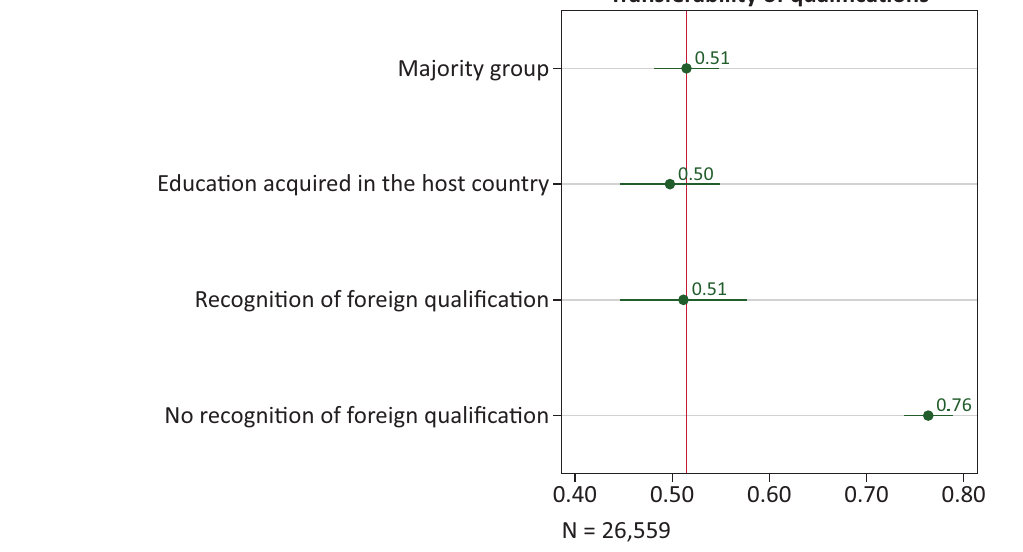
Figure 4. Predicted probabilities of over-education by language skills and transferability of qualifications. Notes: Controls for age, civil status, dependent children and degree of urbanisation; only high-skilled migrants aged 16–64, not in educa- tion/training or retired in 2008; weighted and clustered by